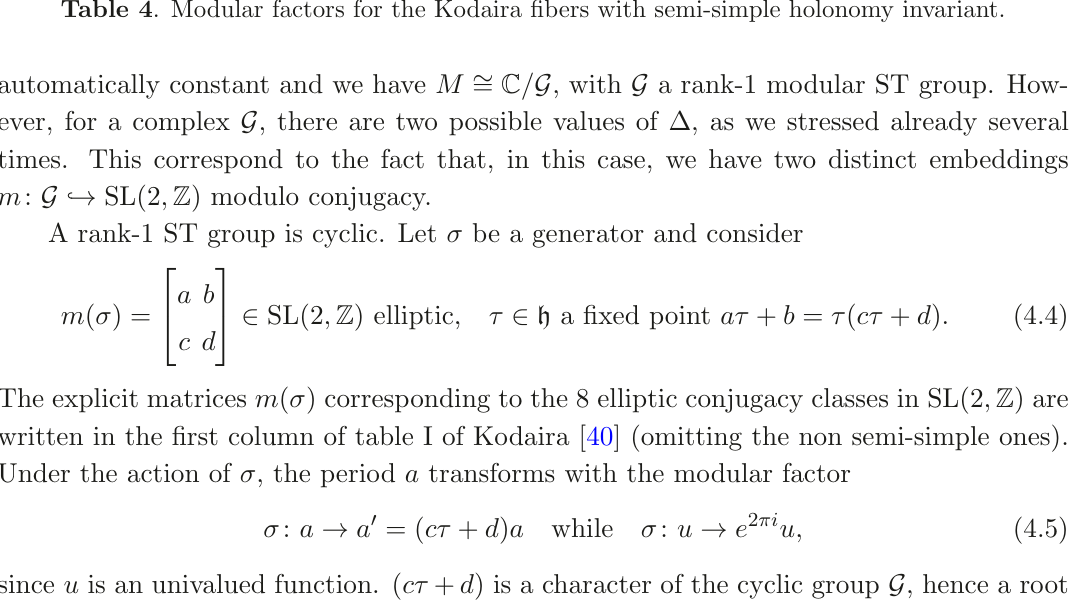
Table 4 . Modular factors for the Kodaira fibers with semi-simple holonomy